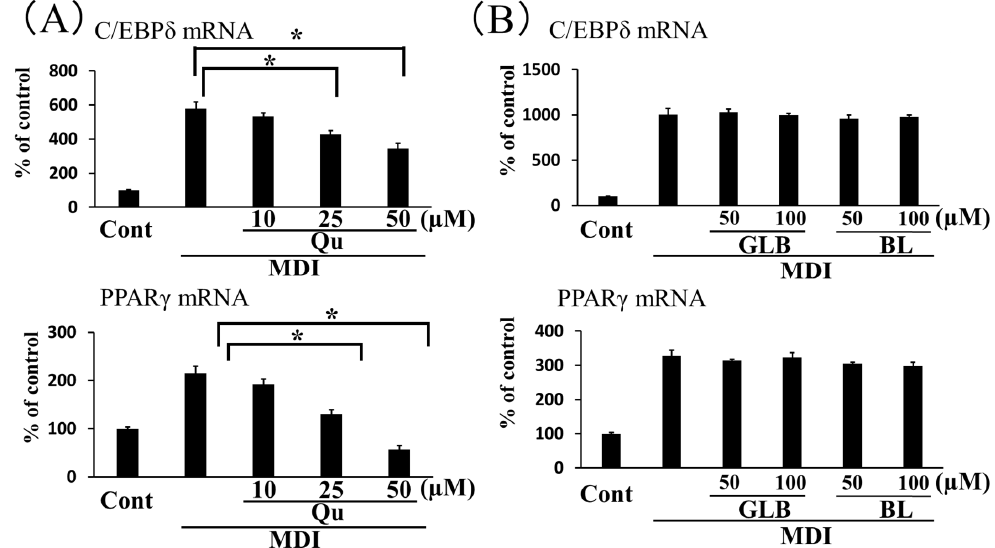
Figure 4. Effects of quercetin (Qu), ginkgolide B (GLB), and bilobalide (BL) on the expression of genes involved in adipocyte differentiation. Qu ( A ), GLB and BL ( B ) were added in conjunction with MDI at the concentrations indicated for 2 days. C/EBPδ (upper panel) and PPARγ (lower panel) gene expression levels are expressed as the % of control cultures (Cont). Data represent the mean ± SD ( n = 3). * p < 0.05.